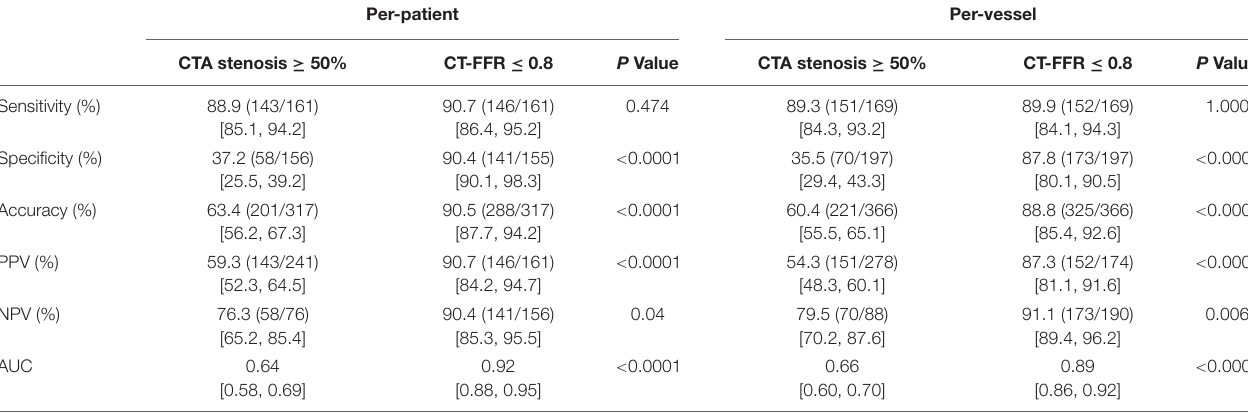
TABLE 3 | Per-patient and per-vessel diagnostic performance of coronary CTA and CT-FFR.